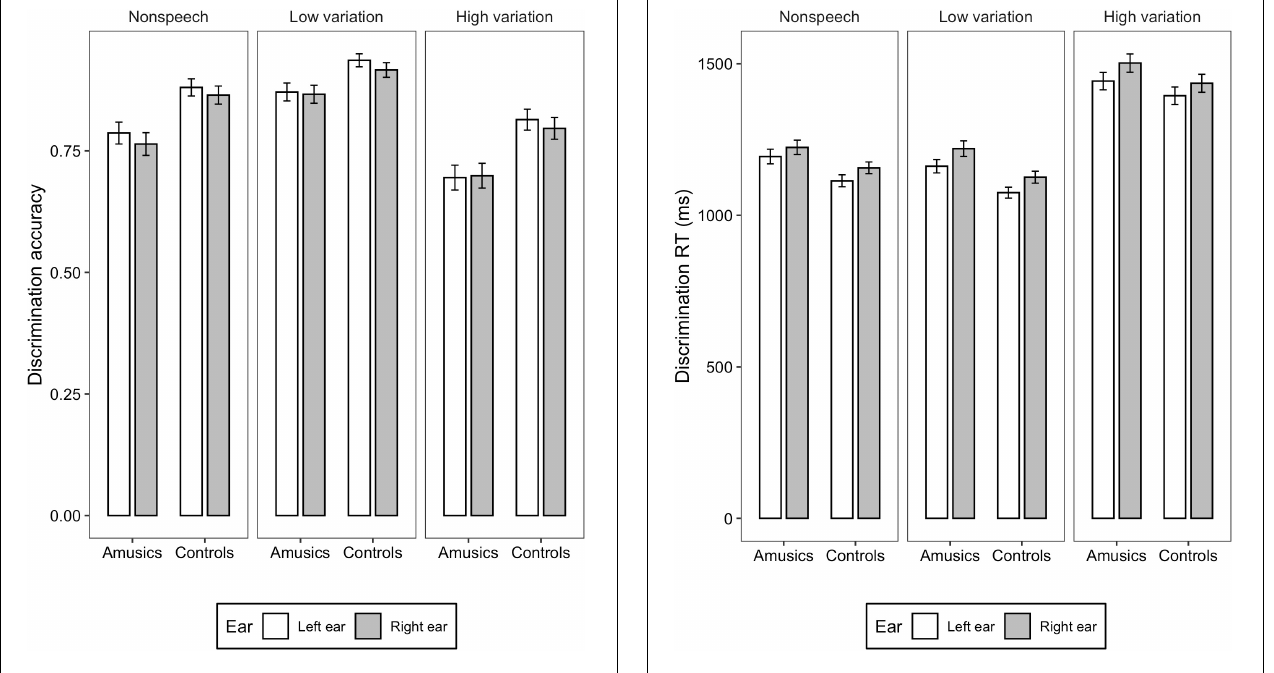
FIGURE 3 | Bar charts showing the discrimination accuracy (means and CIs) in each ear for amusic and control participants in the three stimulus conditions: Non-speech, Low variation, and High variation.